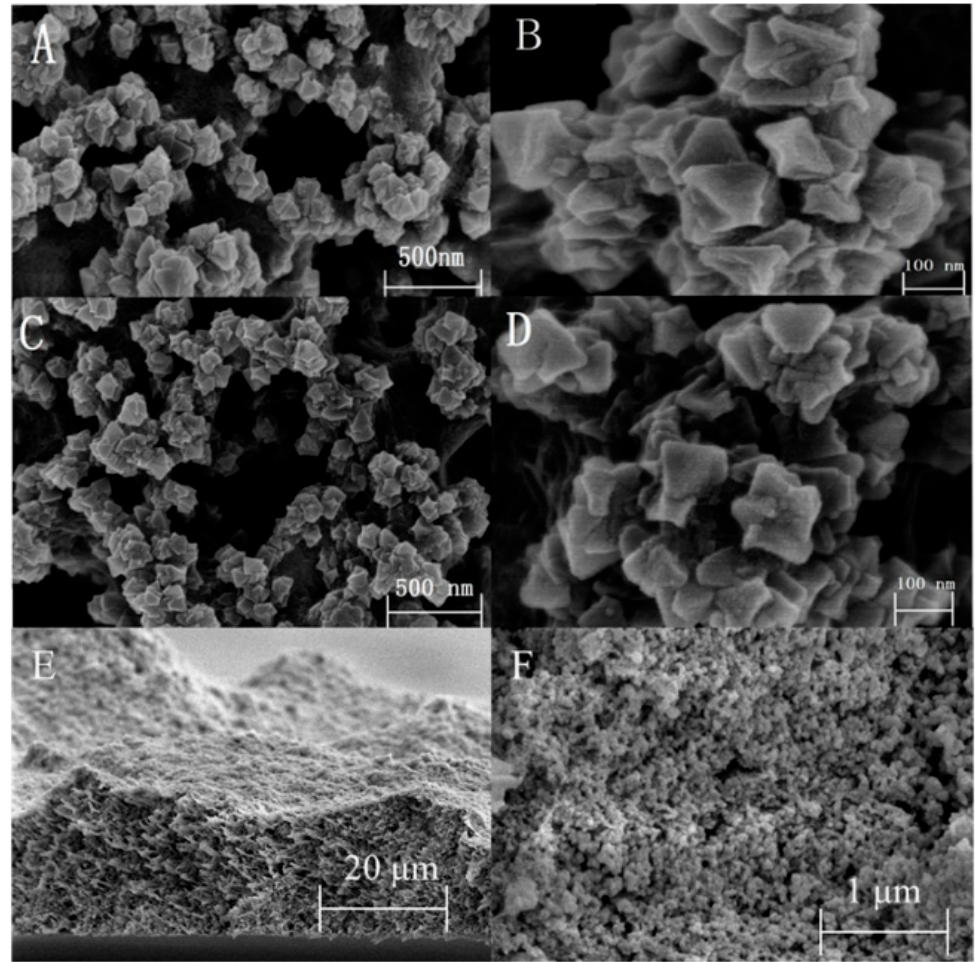
Figure 4. SEM images of UiO-66-NH 2 MMM with the scale bar of ( A ) 500 nm and ( B ) 100 nm. ( C ) UiO-66-NMe 3+ MMM with the scale bar of 500 nm and ( D ) 100 nm. ( E ) Cross-sectional SEM images of UiO-66-NMe 3+ MMM with the scale bar of 20 μ m and ( F ) 1 μ m. Reprinted with permission from Ref. [88]. Copyright (2020) Elsevier.